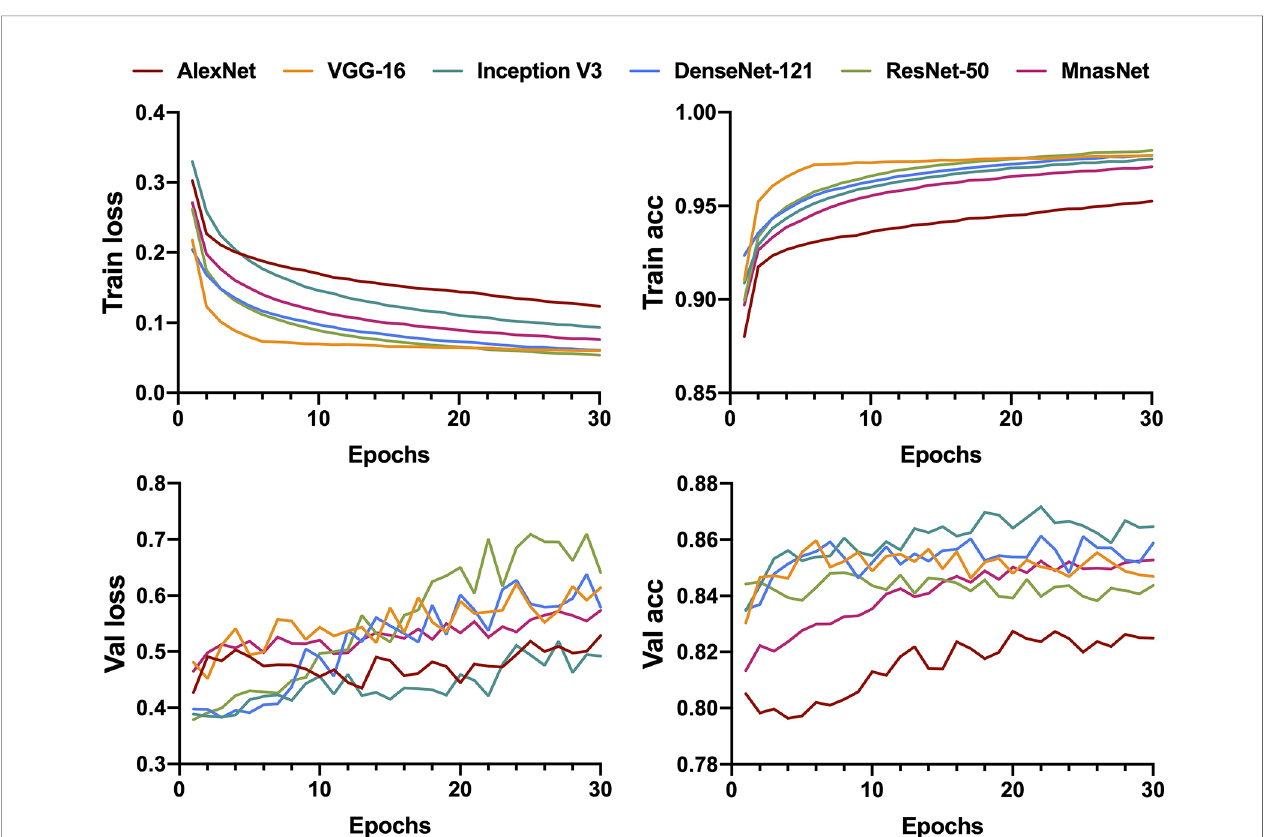
FIGURE 2 | Learning curves for patch-level binary classi fi cation of six models showing the loss and accuracy in training and validation. Train, training; Val, validation; acc,